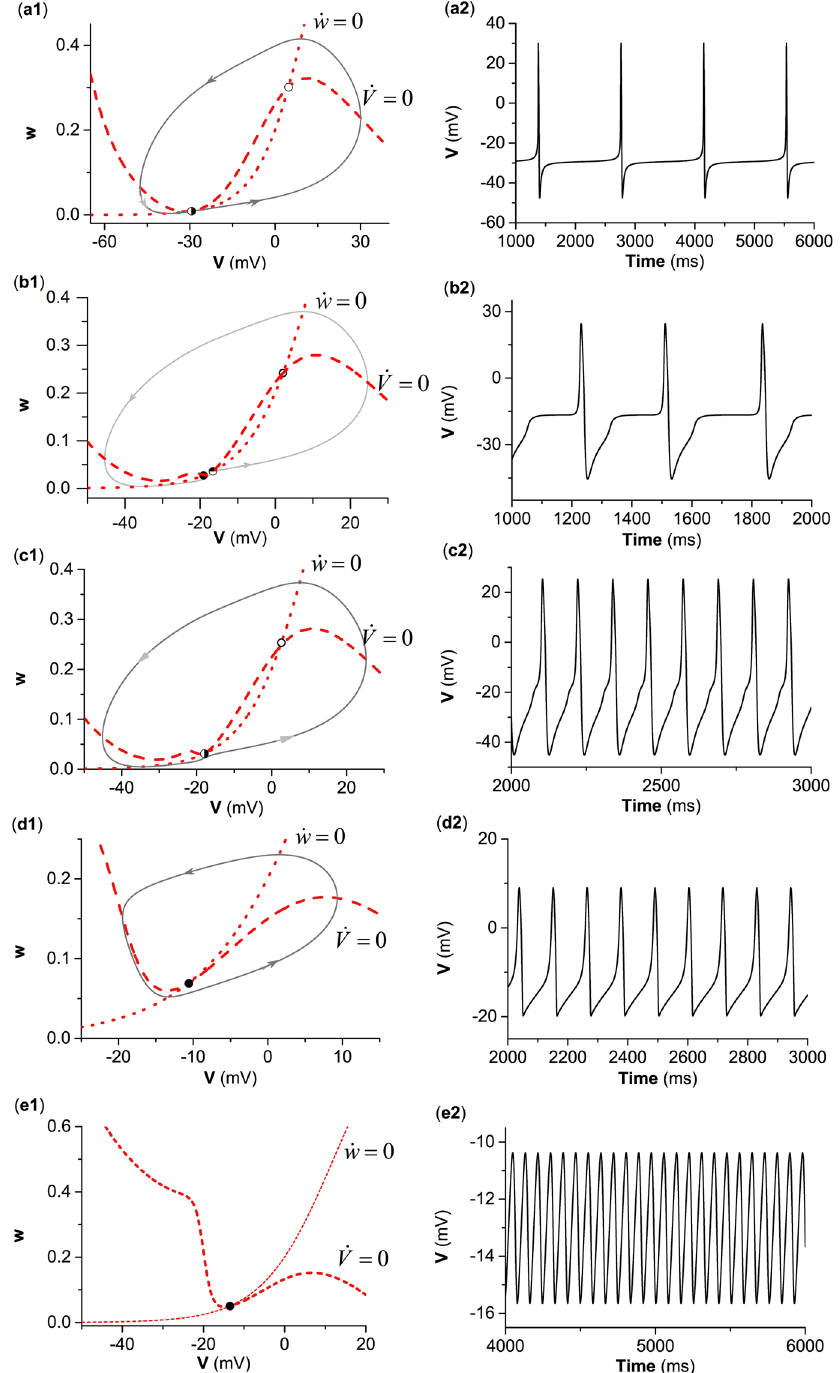
Figure 3. Dynamics corresponding to or near the different bifurcation points. ( a ) SNIC with g inh = 0 μ S/cm 2 ; ( b ) BHom with g inh = 0.5 μ S/cm 2 ; ( c ) SN 4S with g inh = 0.5 μ S/cm 2 ; ( d ) SubH with g inh = 3.5 μ S/cm 2 ; ( e ) SupH at = g inh = 4.4 μ S/cm 2 . Left: nullclines, equilibriums, and limit cycles or orbits in the phase portraits; Right: Spike trains. Parameter values: ( a2 ) I app = 39.98 μ A/cm 2 ; ( b2 ) I app = 43.572 μ A/cm 2 ; ( c2 ) I app = 44.8461 μ A/cm 2 ; ( d2 ) I app = 179.2 μ A/cm 2 ; ( e2 ) I app = 217.39 μ A/cm 2 . In panels (a1–e1), the red dotted line and dashed line represent nullcline =  w 0 and nullcline =  V 0 , respectively. The solid line represents trajectory and arrow indicates